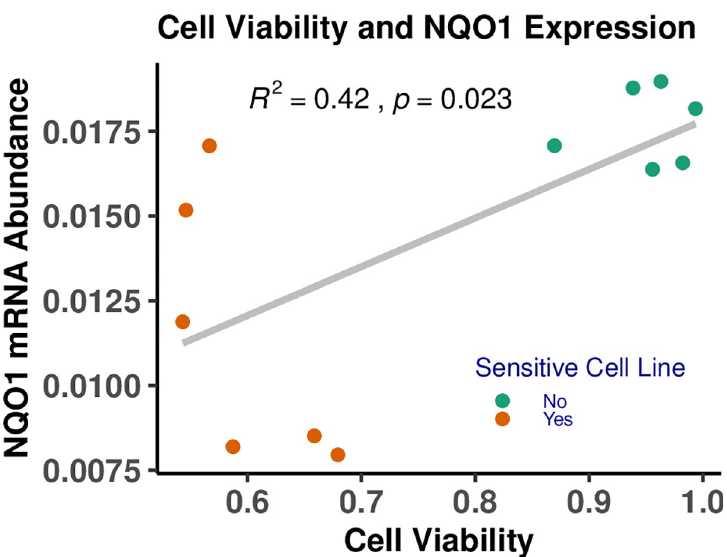
Fig 7. Correlation of NQO1 mRNA expression and cell viability. Increased cell viability was observed with higher levels of NQO1 mRNA expression as measured in 12 LCLs exposed to 0.5 μ M arsenic trioxide. The 12 selected LCLs comprise six sensitive and six resistant cell lines, classified based on their mean viability (AUC values) across the four drug treatments: arsenic trioxide, erlotinib, trametinib, and the paclitaxel + epirubicin combination. Each cell sample was measured in triplicate. The replicates were averaged for each cell